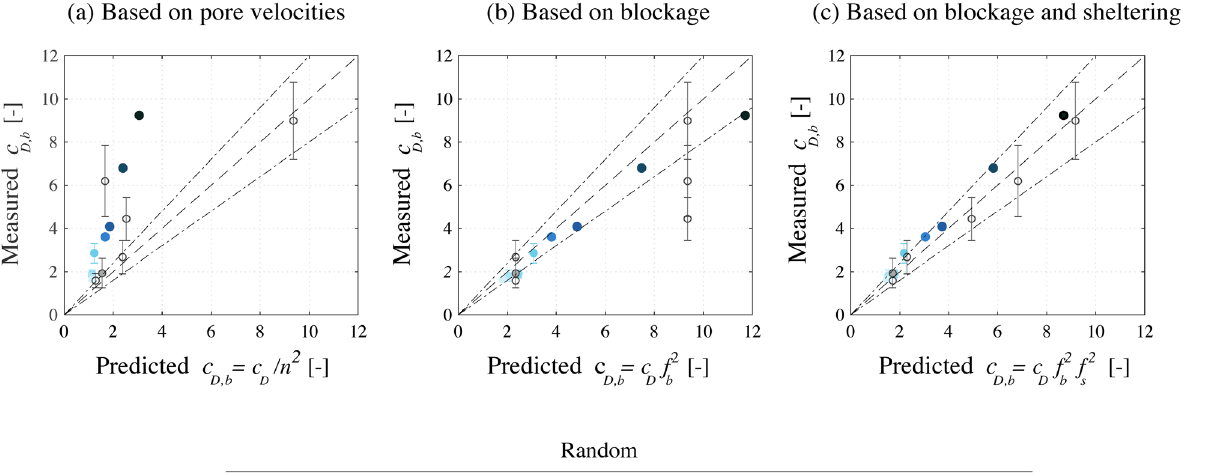
Figure 3. Predictions of the analytical model versus c D , b measurements for random cylinder arrays with varying porosities, by Tinoco and Cowen 22 and Tanino and Nepf 21 , and versus measurements for regular and staggered arrangements by Jansen 29 . Plot ( a ) shows the bulk drag coefficient calculated from the pore velocities (based on mass conservation over the fluid volume). Plot ( b ) shows the drag values derived from blockage factor (based on mass conservation over a cross-section). Plot ( c ) shows the results of the present model, which includes both blockage and sheltering effects. The vertical bars show the estimated measurement